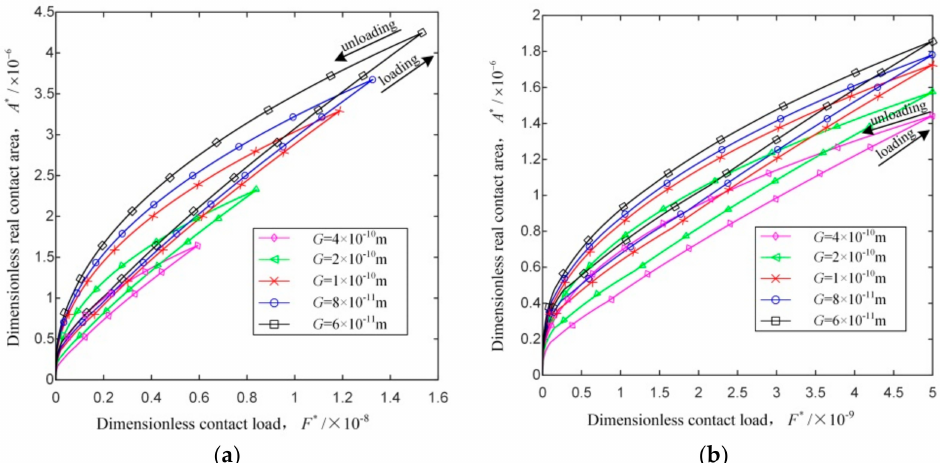
Figure 4. The relation between dimensionless real contact area and dimensionless contact load of two cylindrical surfaces in the second elastoplastic stage with di ff erent profile scaling parameters with D = 1.5, R c1 = 100 mm and R c2 = 60 mm. ( a ) Unloading at the dimensionless critical contact load; ( b ) unloading at a given dimensionless contact load.